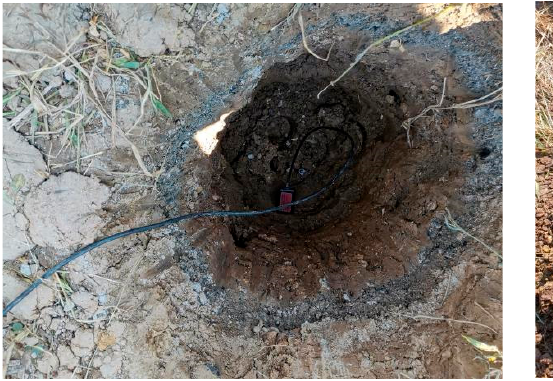
Figure 16. Drilling and